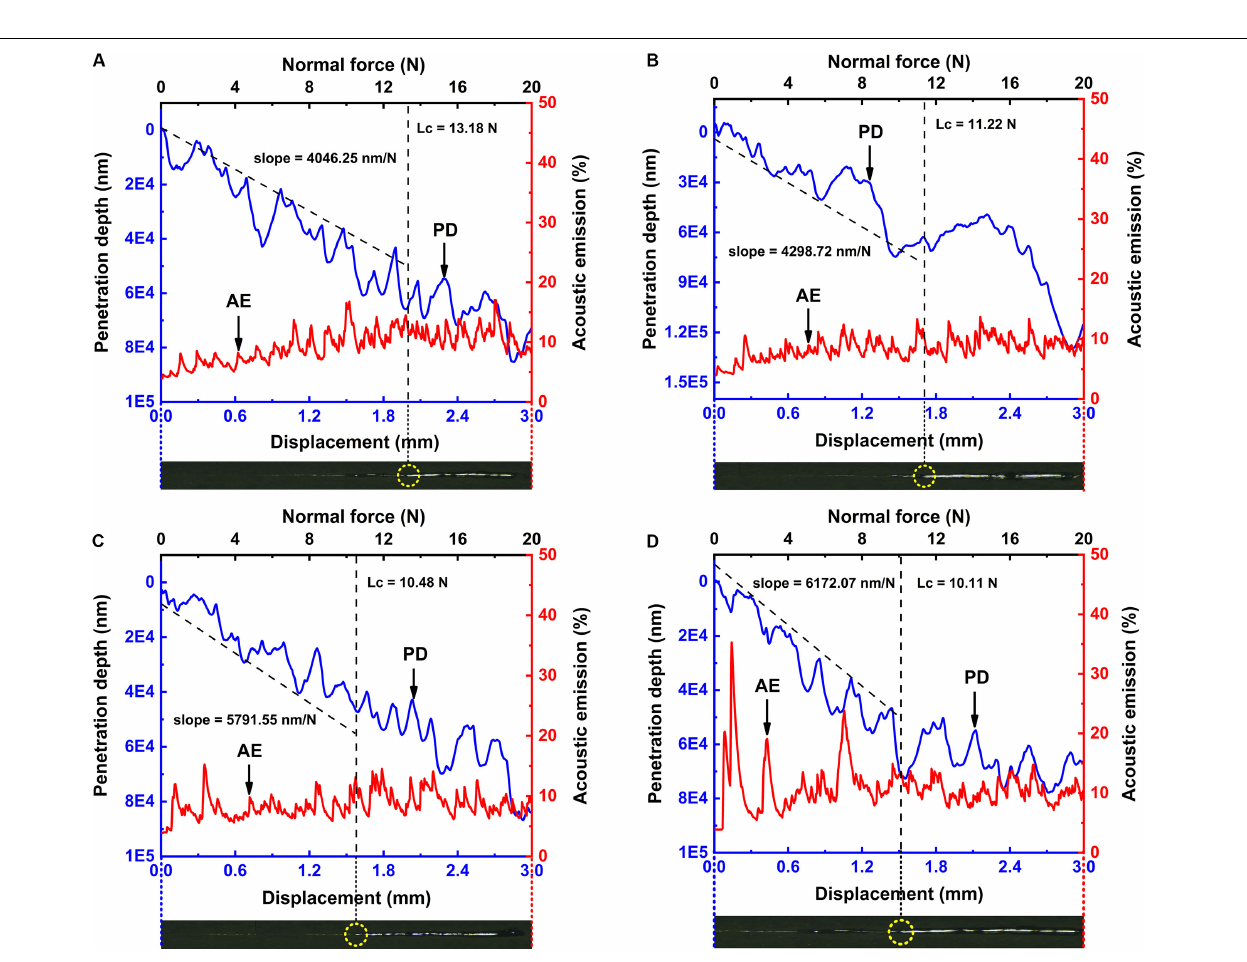
FIGURE 7 | Penetration depth and acoustic emission as a function of scratch load and displacement of MAO coatings under different current modes for (A) 1.2–0.6 A, (B) 1.2–0.8 A, (C) 1.2–1.0 A, and (D) 1.2 A. The images below each curve are the corresponding scratch tracks. The slopes of the penetration depth curves are 4046.25 nm/N for 1.2–0.6 A mode, 4298.72 nm/N for 1.2–0.8 A mode, 5791.55 nm/N for 1.2–1.0 A mode and 6172.07 nm/N for 1.2 A mode, indicating that MAO coating fabricated under 1.2–0.6 A mode is harder than those fabricated under the other three modes. The value of Lc under 1.2–0.6 A mode is 13.18 N,